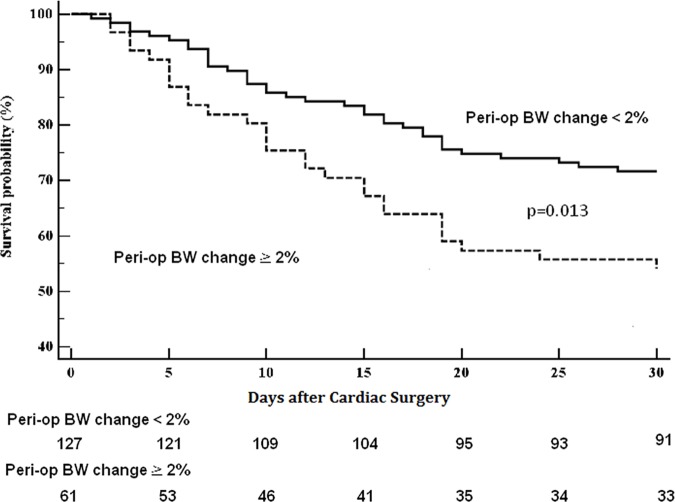
Kaplan-Meier survival curves of the two groups categorized by the perioperative body weight change of 2%.Note: The survival period was calculated from the day of receiving cardiac surgeries. Solid line and dashed line denoted the patients with perioperative BW change < 2% (n = 217) and 2% (n = 61), respectively. The 30-day postoperative mortality was significantly higher in the group with perioperative BW change≧ 2% (45.9%) than those with perioperative BW change < 2% (28.4%) (p = 0.013). Abbreviations: BW, body weight; Peri-op, perioperative.